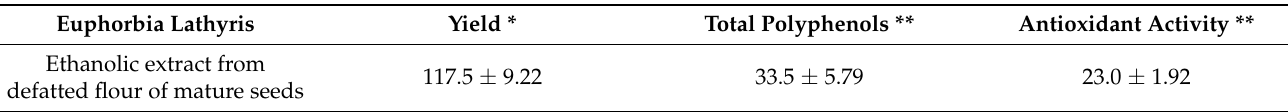
Table 1. Analysis of yield and antioxidant activity of the ethanolic extract from the defatted flour of mature seeds of Euphorbia lathyris . Euphorbia Lathyris Yield * Total Polyphenols ** Antioxidant Activity ** Ethanolic extract from 117.5 ± 9.22 defatted flour of mature seeds